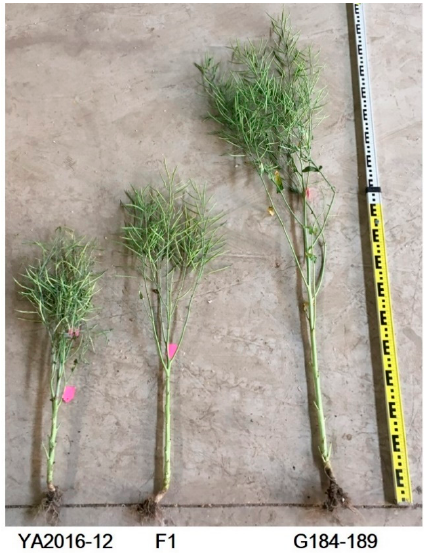
Figure 1. Plant height of dwarf parental YA2016 ‐ 12, tall parental G184 ‐ 189, and an F 1 specimen. The F 1 plant represents the semi ‐ dwarf phenotype.